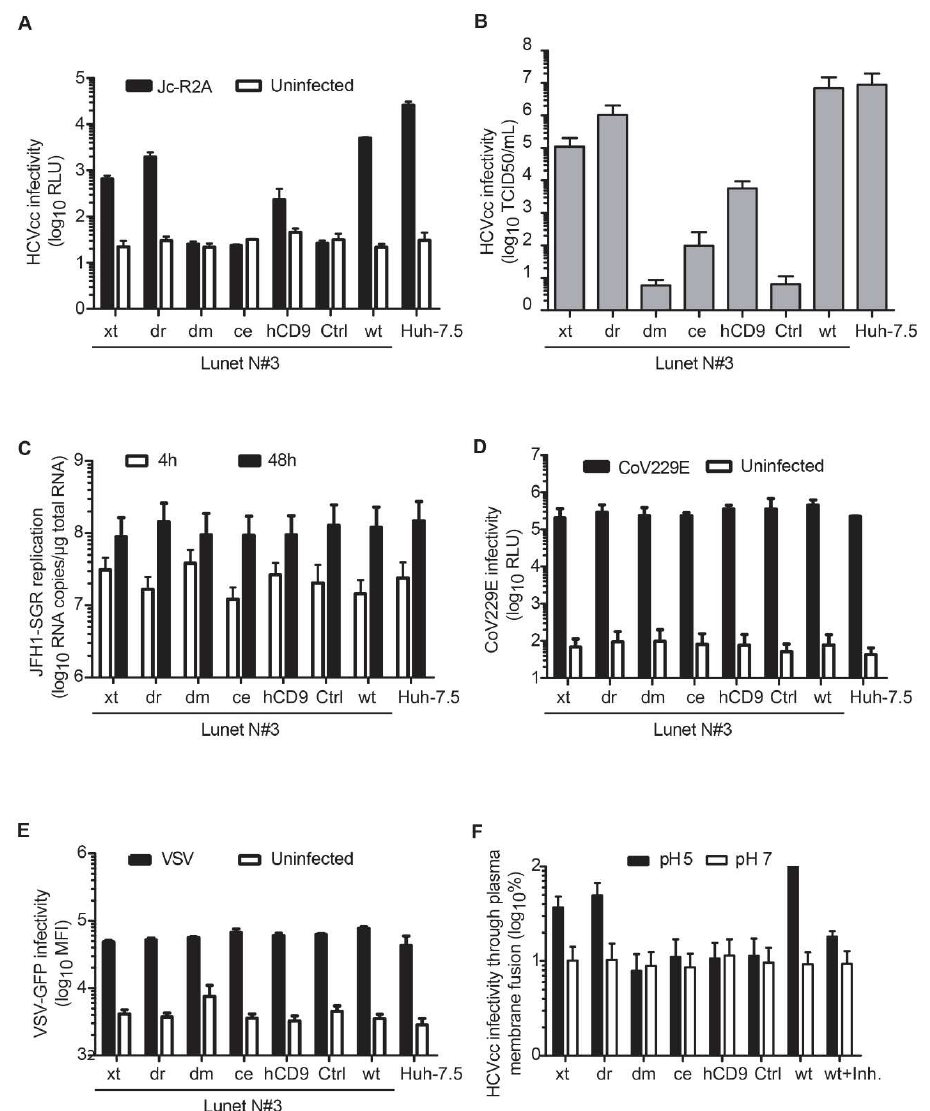
Figure 6. The hCD81 backbone determines HCV infectivity, but not human coronavirus and VSV infectivity. ( A ) Infectivity of a luciferase reporter HCV strain (Jc-R2A) in Lunet N#3 cells expressing hCD81 chimeras and in Huh-7.5 cells. Cells were infected for 72 h at an MOI of 0.5 and infectivity quantified as luciferase activity in cell lysates; ( B ) Infectivity of non-reporter full-length HCV (Jc1) in hCD81 chimera expressing cells. Viral titers at 72 hpi were determined by limiting dilution on Huh-7.5 cells and immunocytochemical staining against the viral NS3 protein; ( C ) Replication assay using an HCV subgenome (JFH-1). Cell lines were electroporated with JFH-1 subgenomic RNA and intracellular viral RNA was quantified by real time PCR at the indicated timepoint; ( D ) Human coronavirus (strain 229E) infectivity determined at 48 hpi using Renilla luciferase reporter virus; ( E ) VSV infectivity determined at 16 hpi using GFP reporter virus; ( F ) HCV (JcR2A) infectivity through artificially induced plasma membrane fusion. Virus was bound in the presence of a V-type ATPase inhibitor and fusion induced at the plasma membrane by a low pH wash. The fusion inhibitor flunarizine (Inh.) served as control. Data shown as mean + SD (SEM in ( F )) of three to five independent biological replicates each performed in technical triplicates.